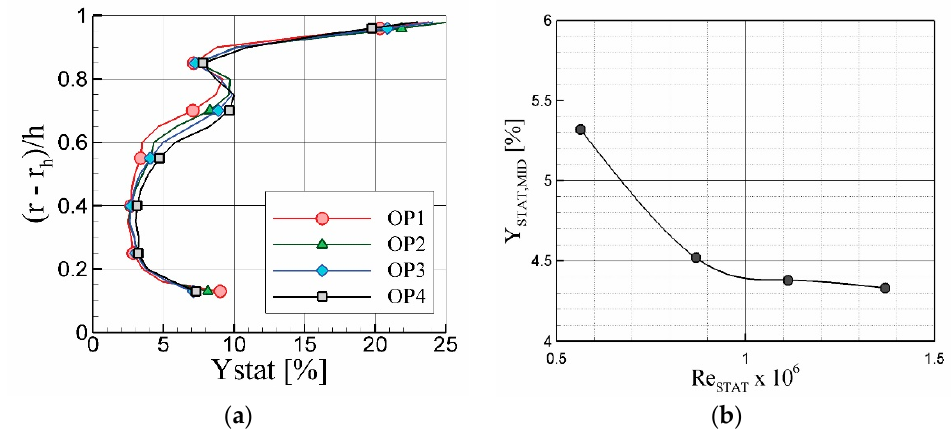
Figure 17. ( a ) Spanwise profile of the stator total pressure loss coefficient; and ( b ) stator profile loss coefficient at midspan vs. Reynolds number.